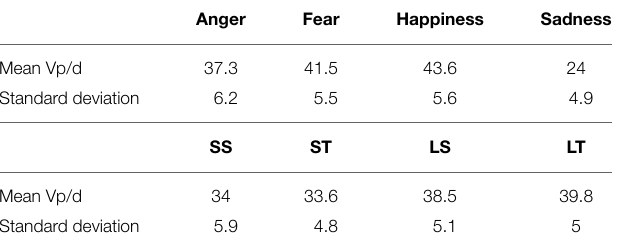
TABLE 7 | Mean Vp/d of the four levels of emotion (anger; fear; happiness; sadness) and the four levels of articulatory constraints (SS, small